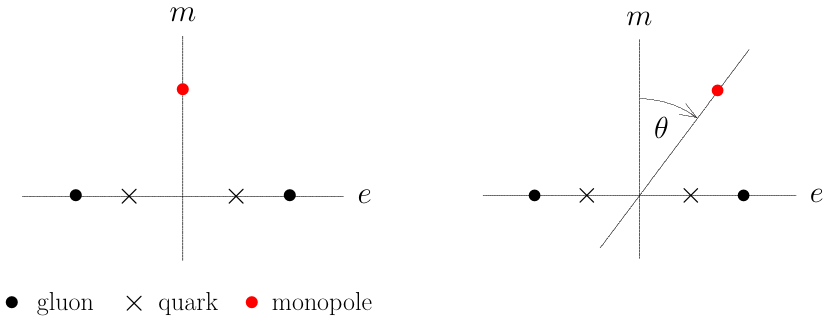
Figure 1: The color-electric – color-magnetic charge lattice for vacuum angle θ = 0 and θ > 0, with regard to the gauge group U(1). Gluons have color-electric charge ± 1, quarks have charge ± 1 / 2, and monopoles have color-magnetic charge ± 1 in Dirac